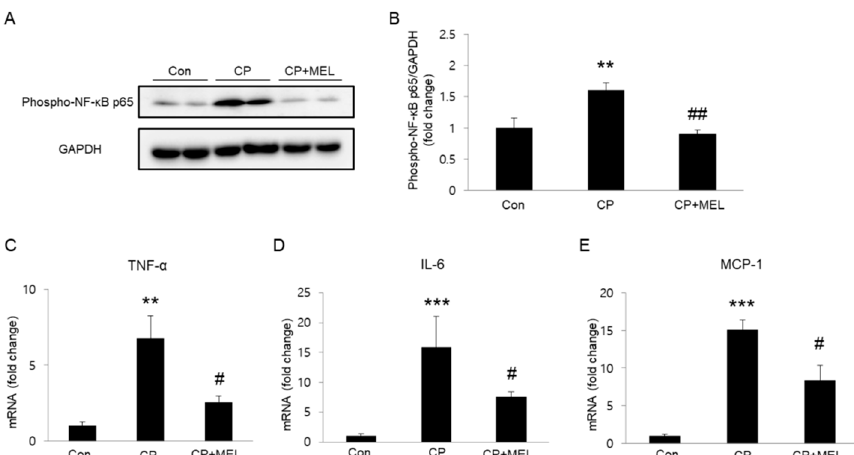
Figure 6. Effects of melatonin (MEL) on renal inflammation in mice treated with cisplatin (CP). ( A ) Western blots of phospho-nuclear factor- κ B (NF- κ B) p65 level in kidneys. ( B ) Quantification of phospho-NF- κ B p65 level. Real-time reverse transcription polymerase chain reaction (RT-PCR) analysis of tumor necrosis factor- α (TNF- α ) ( C ), interleukin-6 (IL-6) ( D ), and monocyte